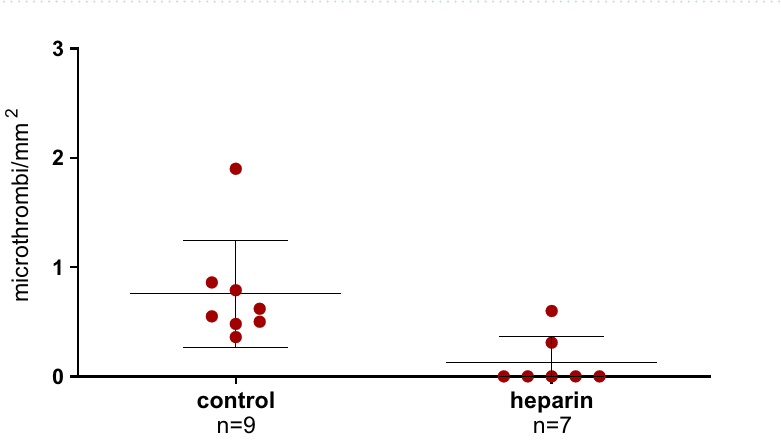
Figure 5. Kidney biopsies stained with Martius Scarlet Blue (MSB) stain. Fibrin stains red, collagen blue, red blood cells yellow. (a) Preimplantation biopsy with microthrombus in peritubular capillary, (b) reperfusion biopsy with microthrombus in peritubular capillary, (c) preimplantation biopsy with fibrin deposition on endothelial lining of peritubular capillary, (d) reperfusion biopsy with multiple microthrombi in glomerulus. (×40 magnification).